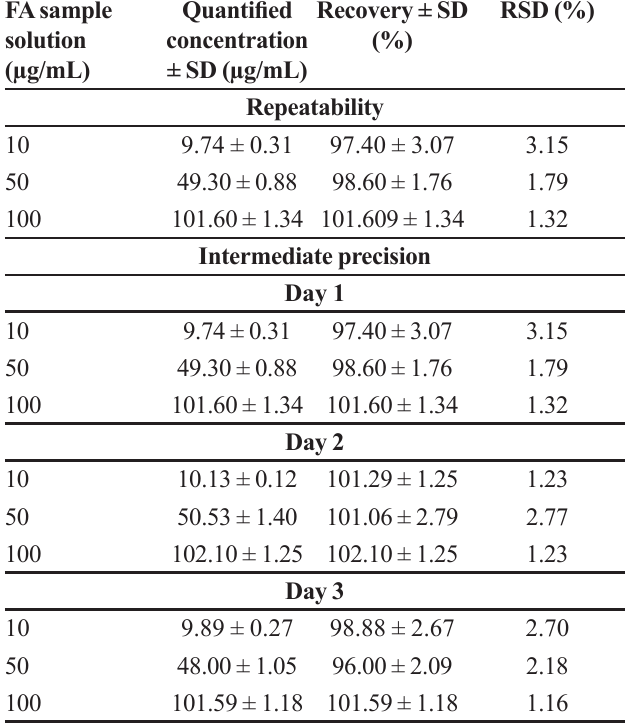
TABLE II - Precision assay: repeatability and